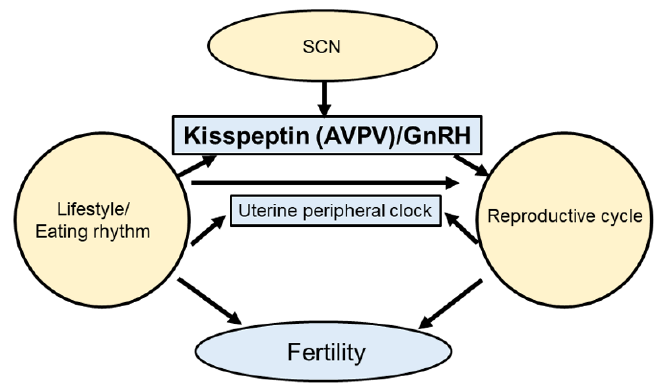
Figure 1. Synchrony of the circadian clock and reproduction. The central clock controls kisspeptin secretion. Feeding rhythms also control hormone secretion. Moreover, circadian clocks and reproduc- tive cycles affect fertility.